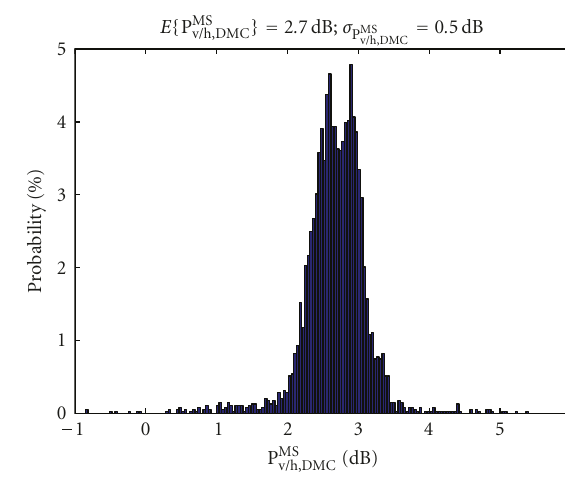
Figure 13: PDF of the P MS